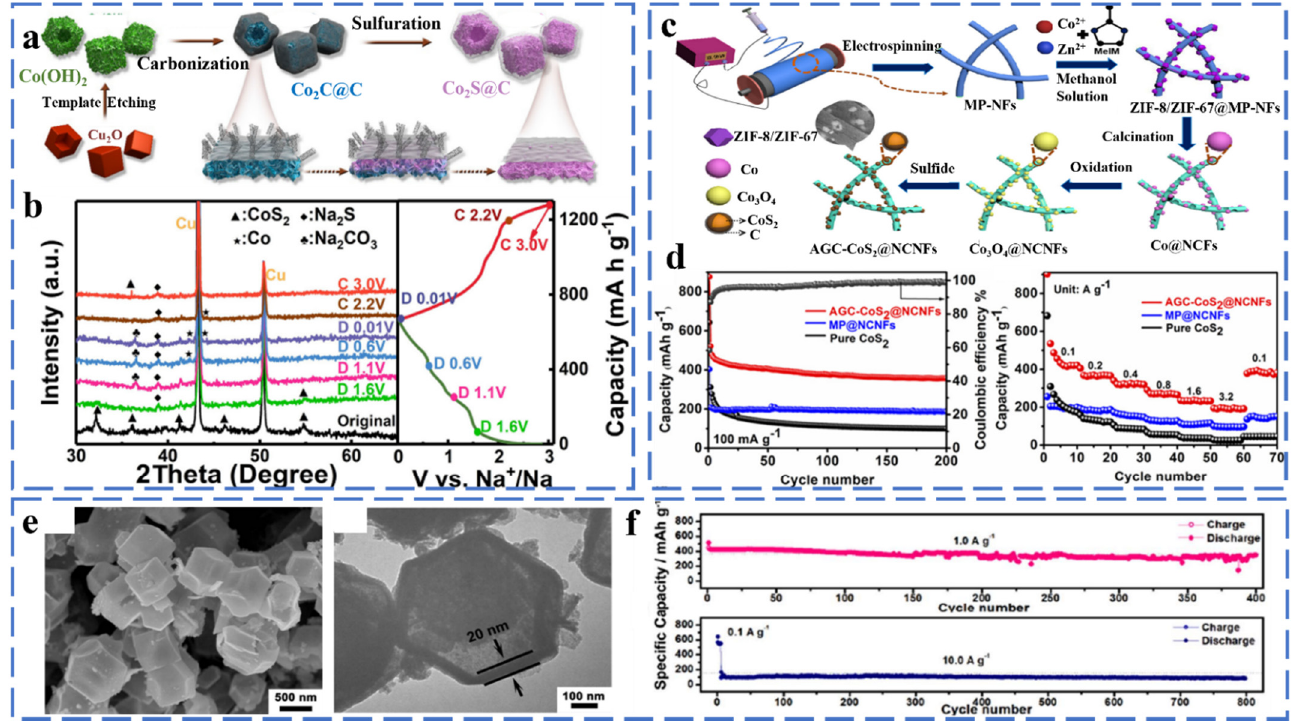
Figure 3. ( a ) Schematic illustration of the synthesis route for the CoS 2 @C composite, ( b ) Ex situ XRD patterns of the CoS 2 @C at various discharging/charging states. Reprinted with permission from Ref. [39]. Copyright 2020, copyright Zhao, Z. ( c ) Schematic illustration of the synthesis of AGC-CoS 2 @NCNFs, ( d ) Cycling performance and rate capability of AGC-CoS 2 @NCNFs, pure CoS 2 and MP@NCNFs. Reprinted with permission from Ref. [40]. Copyright 2020, copyright Zhang, W. ( e ) SEM and TEM images ( f ) long-term cycle stability at 1.0 and 10.0 A g − 1 of Co 9 S 8 @CYSNs. Reprinted with permission from Ref. [41]. Copyright 2020, copyright Zhao, Y.